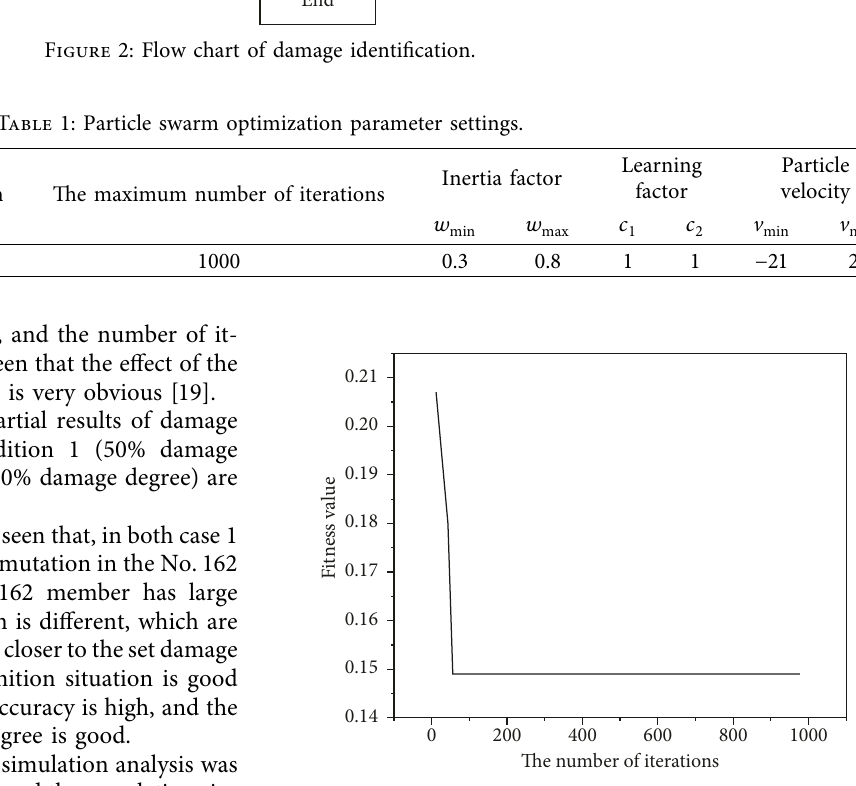
Figure 3: Particle iteration diagram of working condition